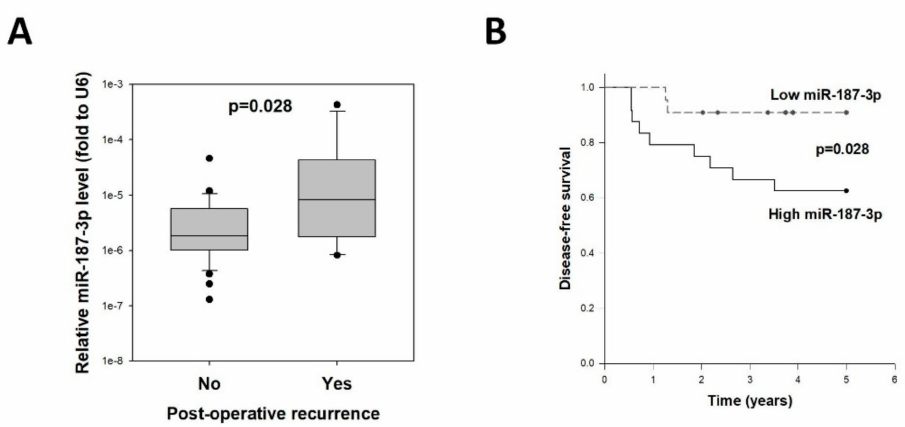
Figure 6. High tumor miR-187-3p levels were correlated with postoperative recurrence: ( A ) Tumor miR-187-3p levels in CRC patients with no recurrence ( n = 35) or with recurrent disease ( n = 11) within 5 years following R0 resection for stage I–III CRC. ( B ) Disease-free survival curves for CRC patients with high or low tumor miR-187-3p